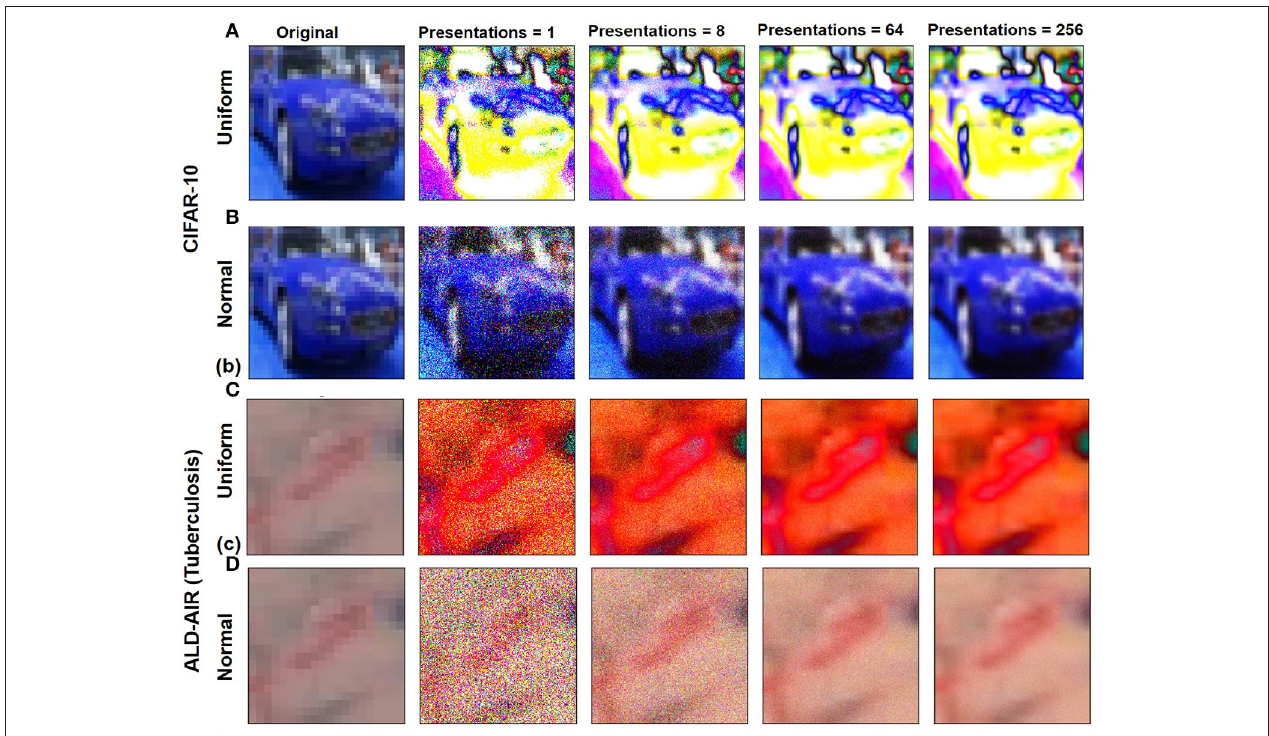
FIGURE 3 | Variation in stochastic input representations based on N pre and for CIFAR-10 image sample by stochastic sampling using distributions: (A) Uniform and (B) normal. Variation in stochastic input representations based on N pre and for ALD-AIR image sample by stochastic sampling using distributions: (C) Uniform and (D) normal.